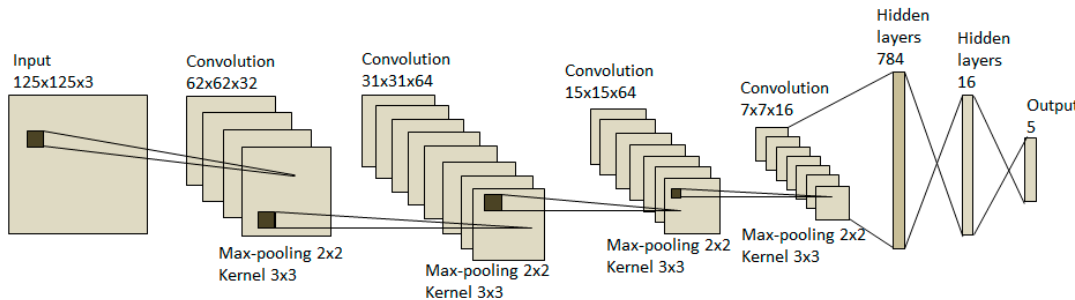
Figure 2. The proposed CNN model architecture.